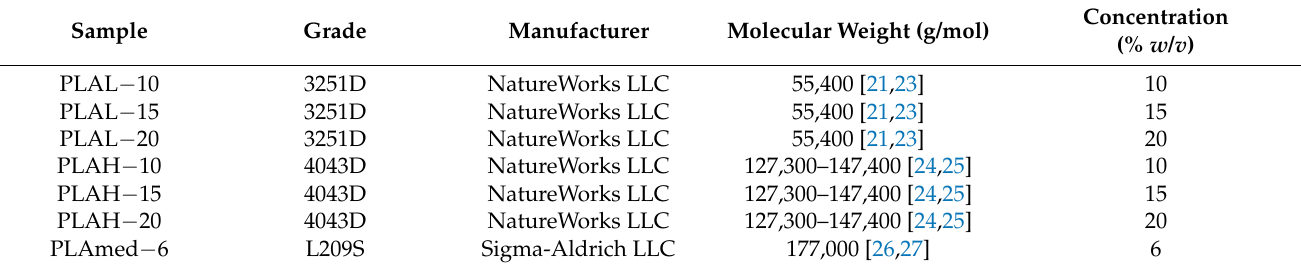
Table 1. PLA sample nomenclature.